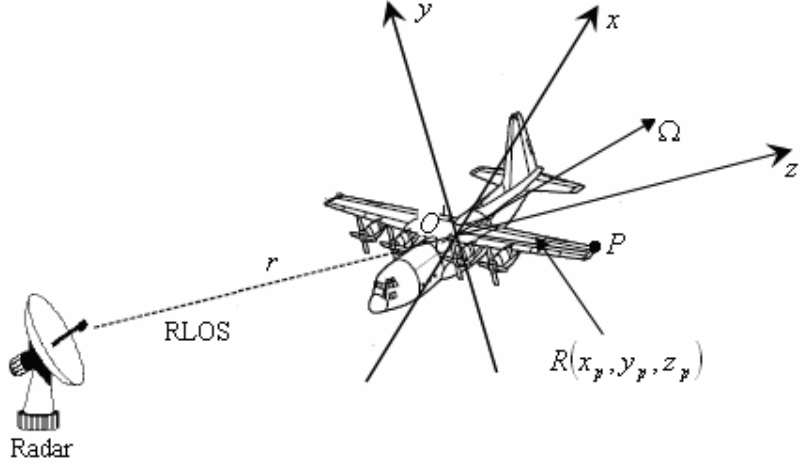
Figure 1. Radar imaging geometry of target with non-uniform